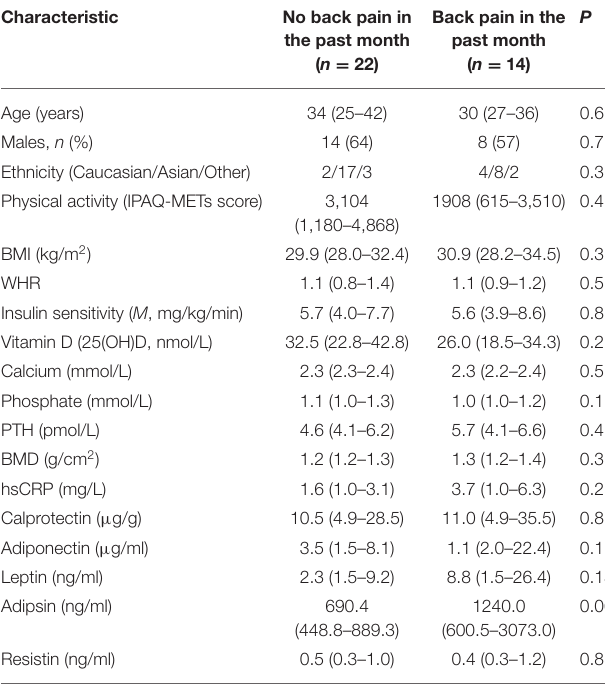
TABLE 1 | Participant